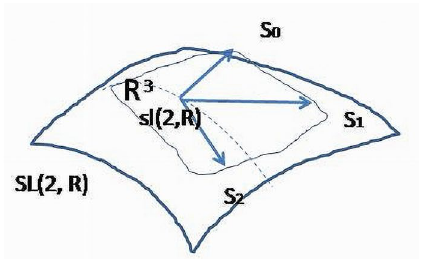
Figure 7. NFB (S 0 ), PFB (S 2 ) and RL (S 1 ) (PNR) matrices as basis elements of Lie algebra sl (2, R ) of